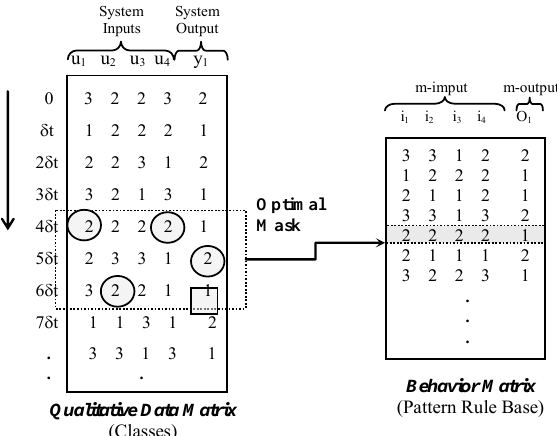
Fig. 2. Process of flattening dynamic relationships into pseudo-static relationships using a mask